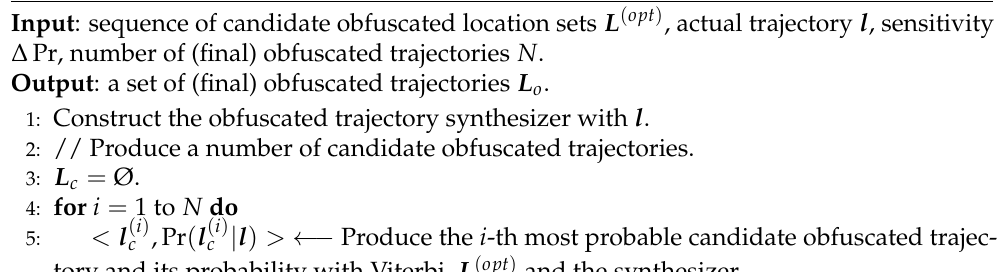
Algorithm 4 Private synthesizing obfuscated